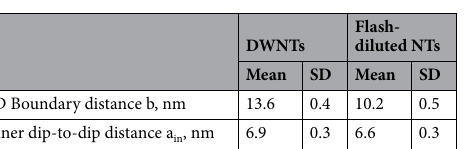
Table 1. Parameters of the distributions of boundary and dip-to-dip distances of DWNTs and flash-diluted